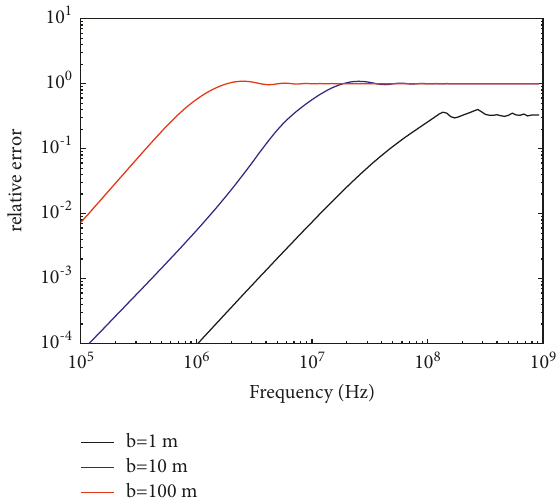
Figure 2: Amplitude-frequency spectrum of the H center of the two loops.